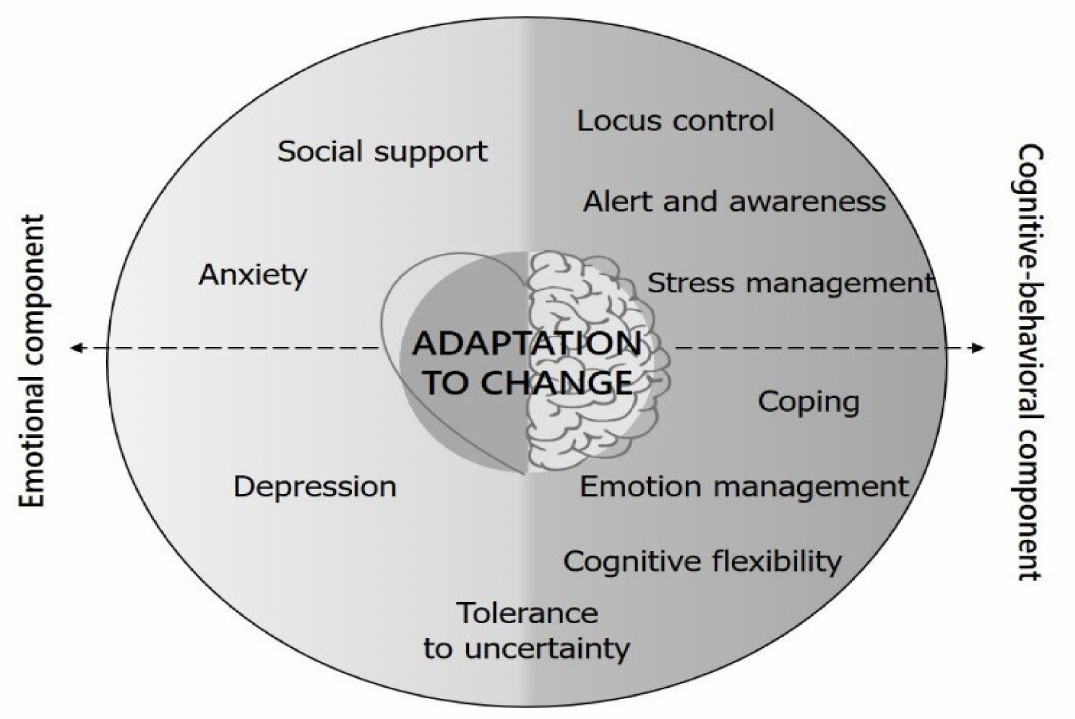
Figure 1. Theoretical explanatory model of the adaptability to change